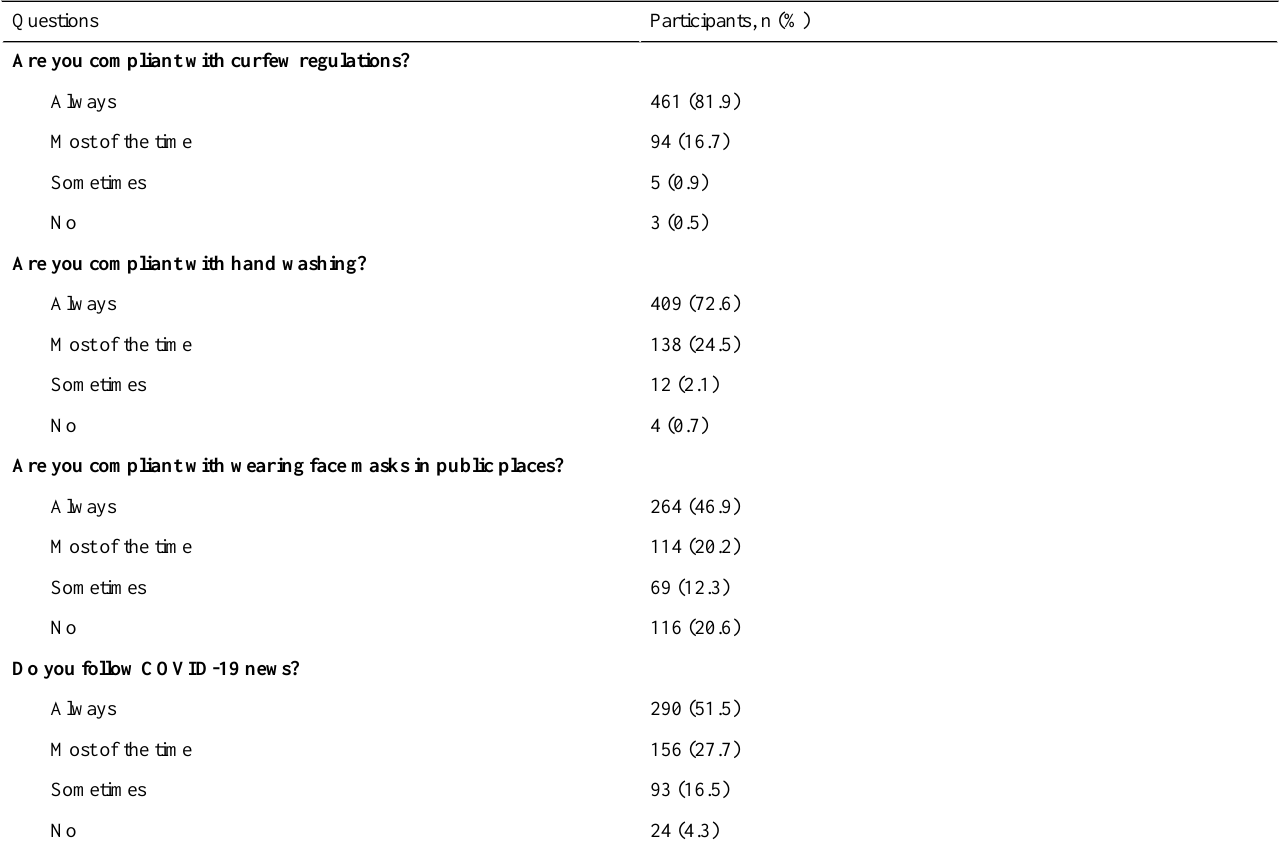
Table 3 summarizes the attitude of health care workers toward COVID-19. Among them, 461 (81.9%) were always compliant with curfew regulations. Most (n=409, 72.6%) health care workers were always compliant with hand washing. With Table 3. Attitudes of health care workers in Saudi Arabia toward COVID-19